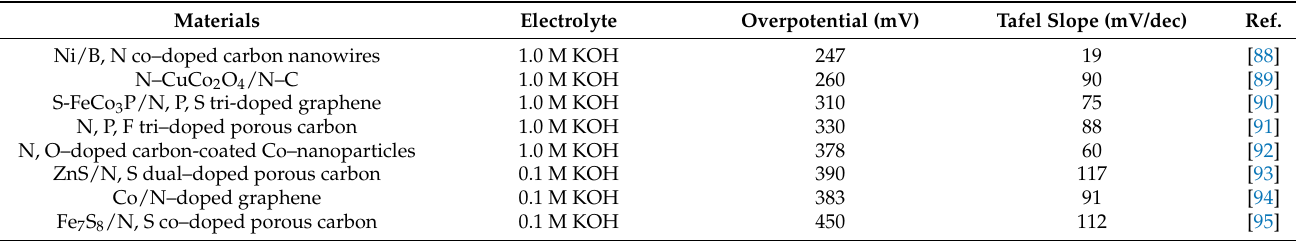
Table 1. Non–metal heteroatom doping to carbon framework for OER electrocatalysts. Materials Electrolyte Overpotential (mV) Tafel Slope (mV/dec)